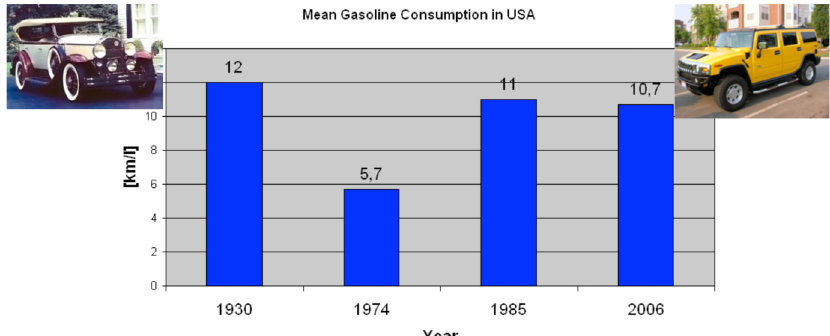
Fig. 2. Mean gasoline consumption in USA vs.